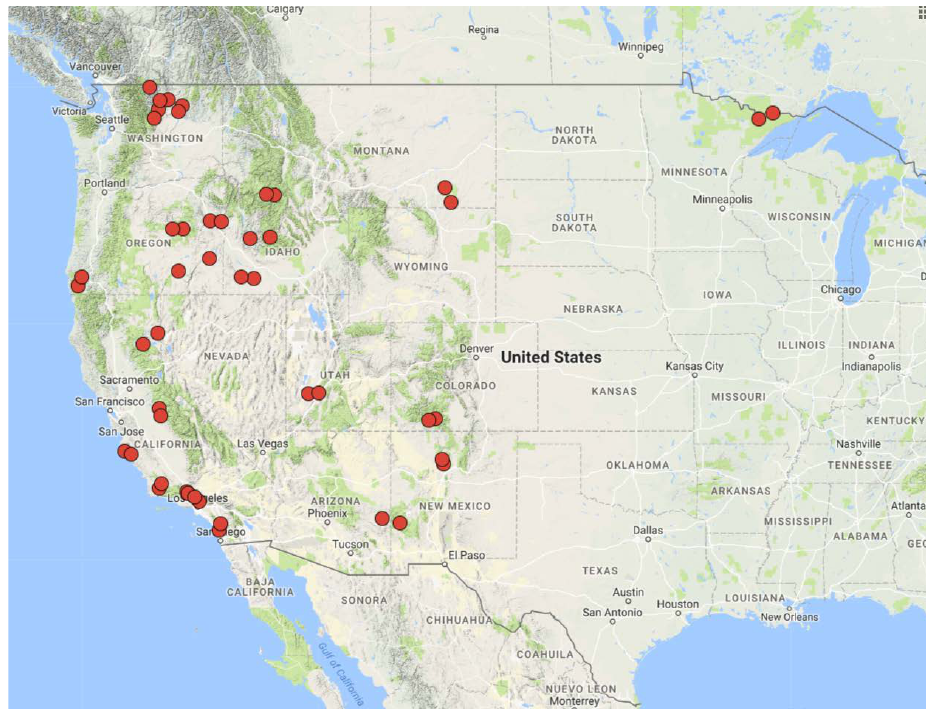
Figure 1. Locations of the 47 fires used in this study.